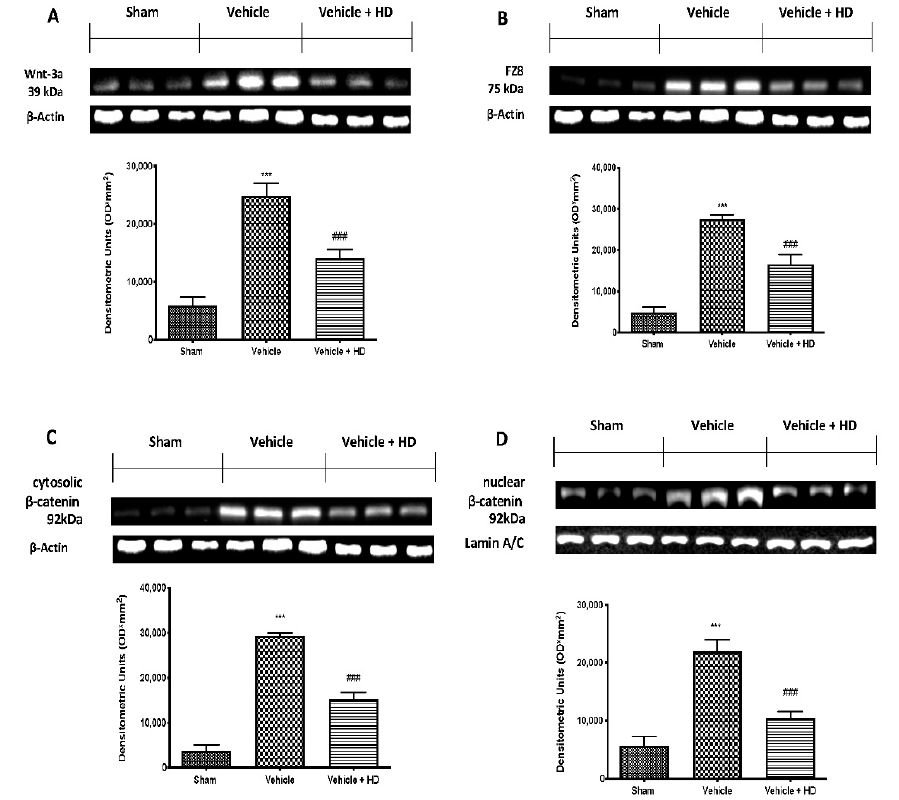
Figure 1. Effect of HD on WNT/FZ/ β -catenin signaling pathway: Western blot analysis of Wnt-3a ( A ), FZ8 ( B ), cytosolic β -catenin ( C ) and nuclear β -catenin ( D ) expression. *** p < 0.001 vs. sham; ### p < 0.001 vs. vehicle.